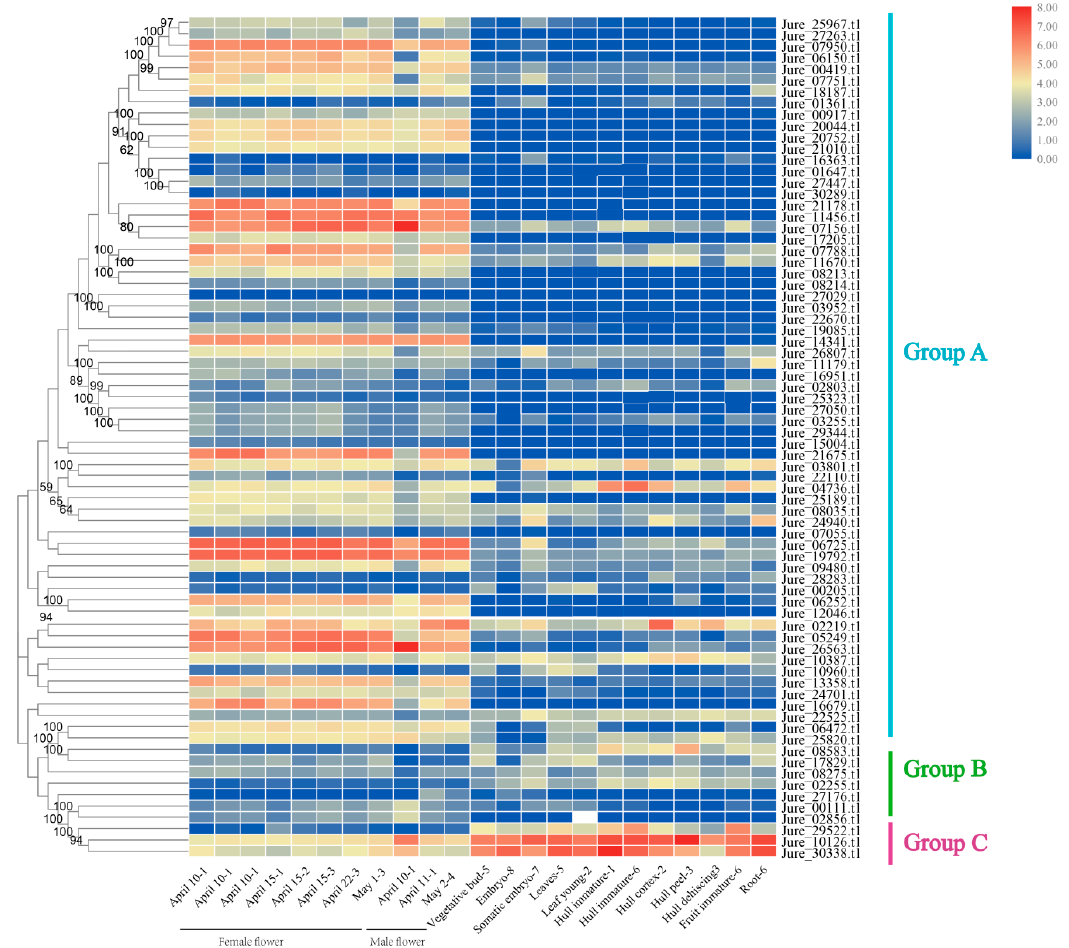
Figure 4. Expression patterns in multiple tissues of common walnut. RNA sequencing (RNA-Seq) data of all tissues in common walnut were used to analyze the expression pattern. The heat map was drawn in log 10 -transformed expression values. Red and green represent relatively high and low expression compared to the control, respectively.